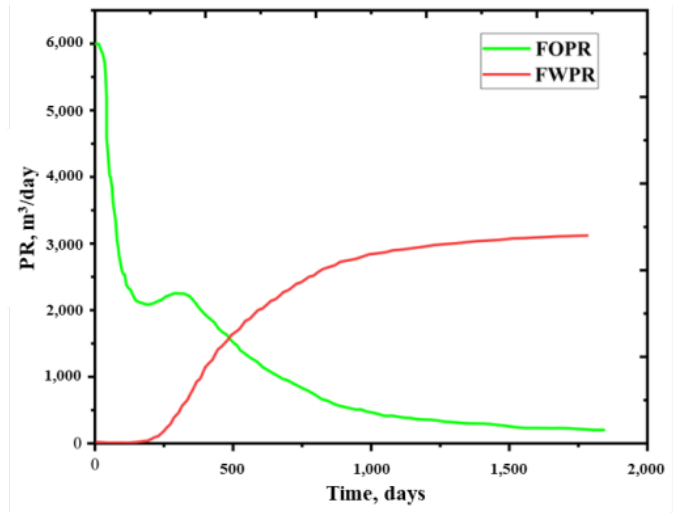
Figure 15. Field oil production rate and field water production against time for horizontal wells.